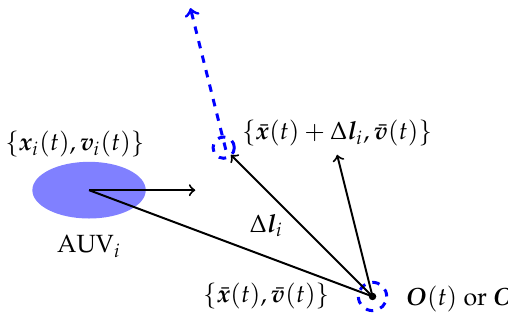
Figure 1. The example of leaderless